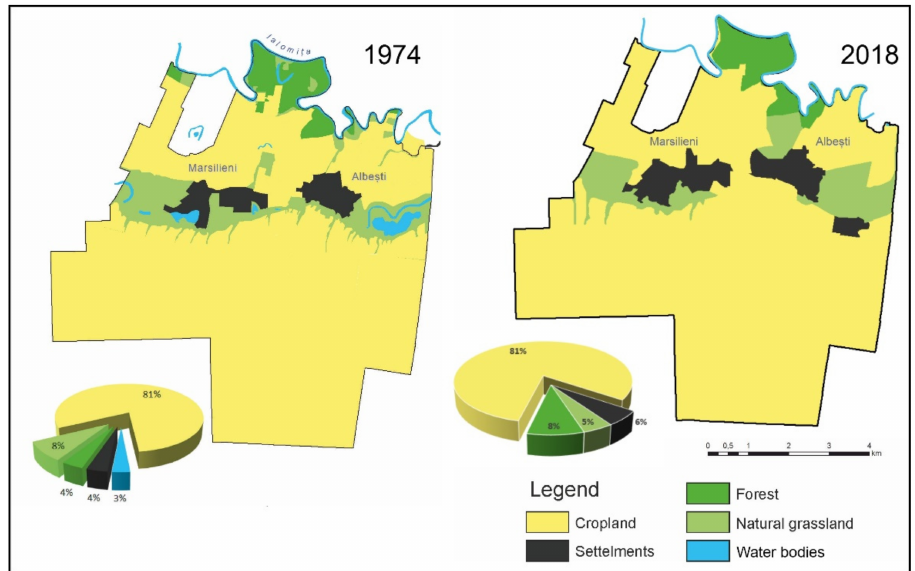
Figure 10. Spatial distribution of land resources in 1974 and 2018 in Albes